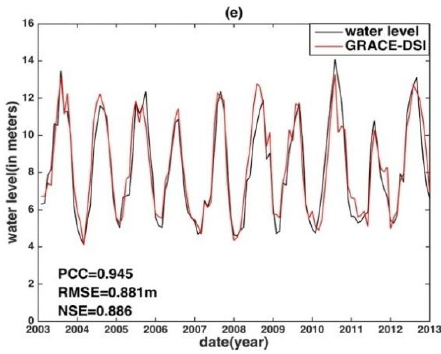
Figure 7. Water level reconstruction at Datong station based on various indices including SST anomalies in ( a ) Niño 3.4; ( b ) SOI; ( c ) MEI; ( d ) PDSI; and ( e ) GRACE-DSI.